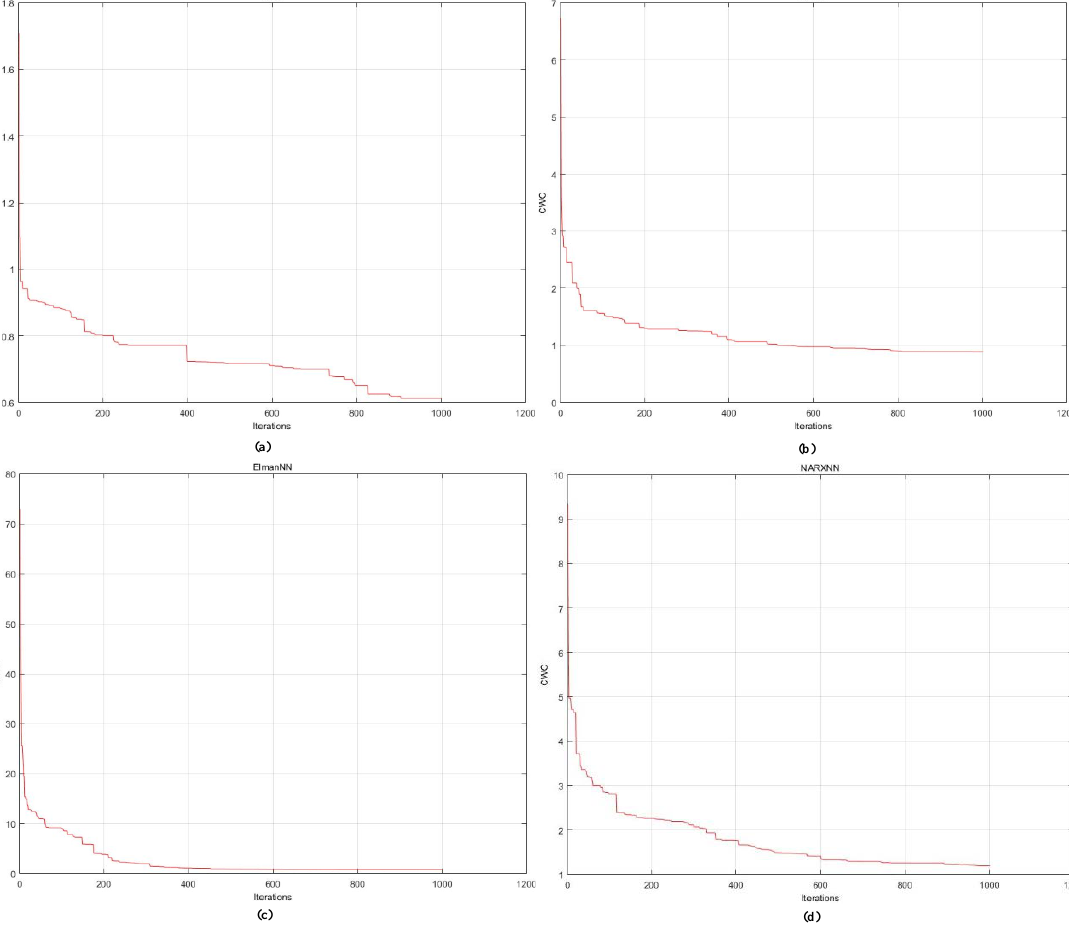
Figure 11. The comparative results for the CWC value of the best population by four prediction models on the training data: ( a ) The CWC obtained by DBN; ( b ) the CWC obtained by BP network neural; ( c ) the CWC obtained by Elman network neural; ( d ) the CWC obtained by NARX network neural.